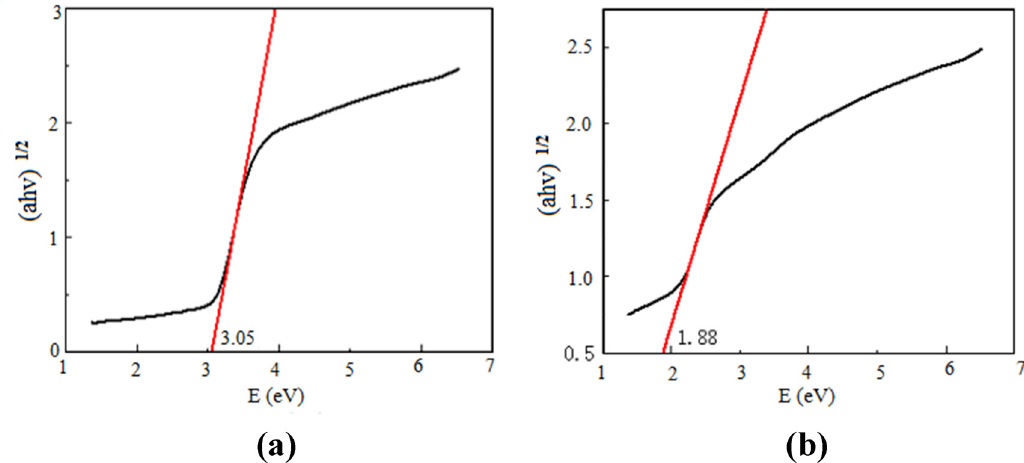
Figure 9: Band gap width of TiO 2 and CdS/TiO 2 composite photocatalysts. ( a ) TiO 2 , ( b ) CdS/TiO